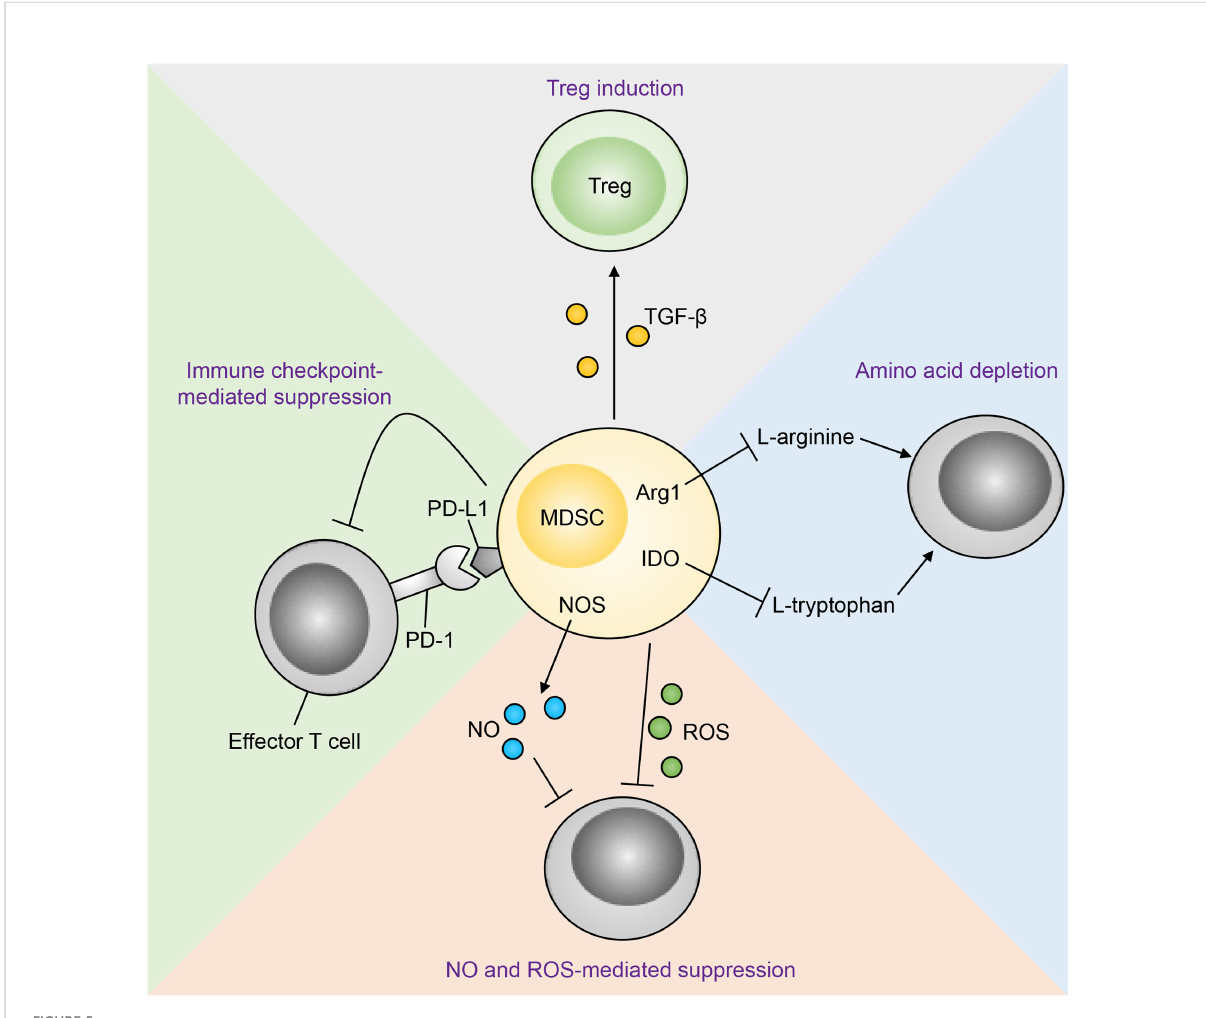
FIGURE 5 Mechanisms of MDSC-mediated T cell suppression. Immunosuppression of effector T cells by MDSCs occurs through multiple mechanisms. MDSC-derived nitric oxide (NO) and reactive oxygen species (ROS) inhibit T cell effector function and promote apoptosis. MDSCs can